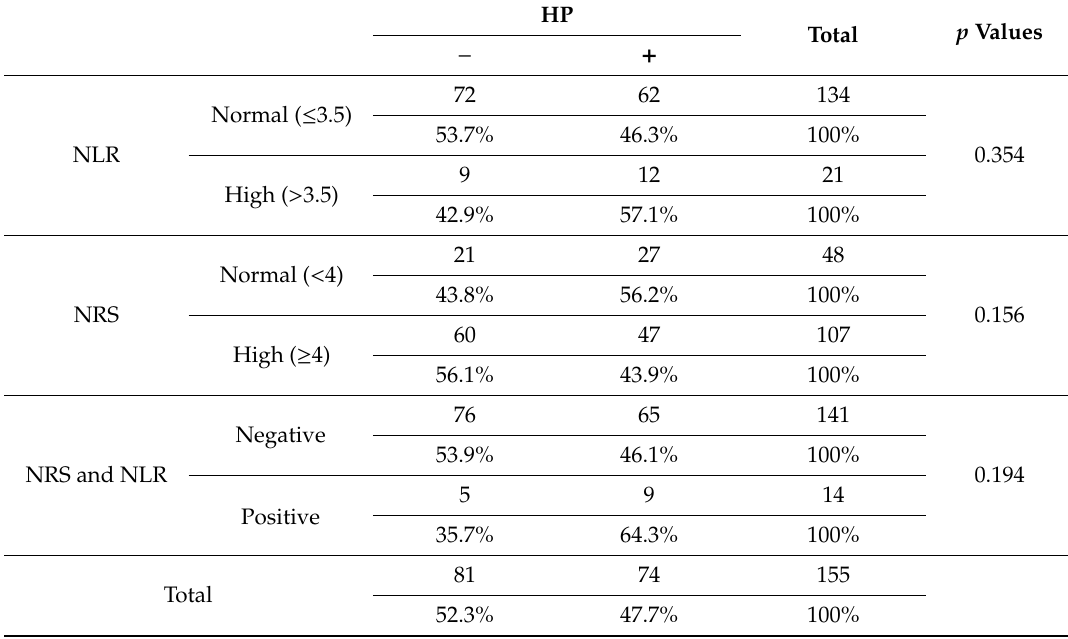
Table 3. Comparison of HP incidence according to neutrophil to the lymphocyte ratio (NLR) and numerical rating scale (NRS) levels.